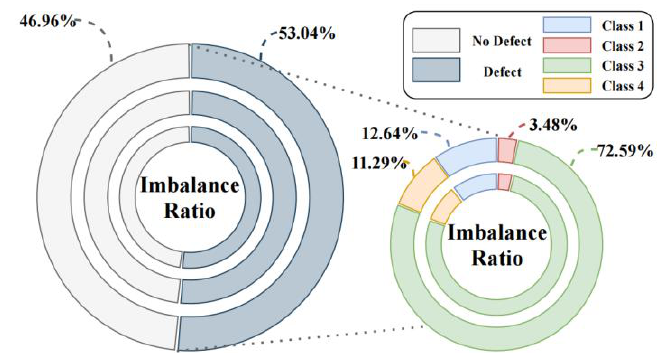
Figure 3. Imbalance ratio of steel defect images in the Severstal dataset.